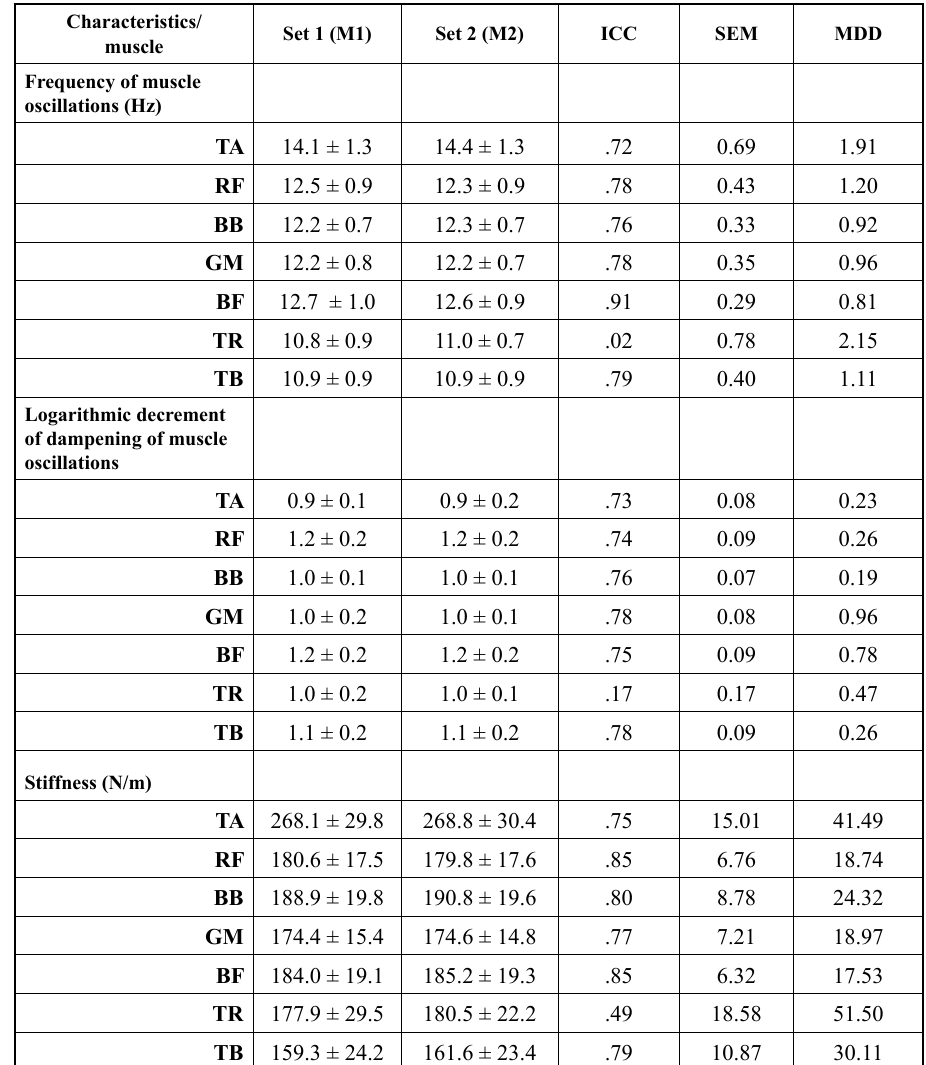
BB, GM and TB frequency measurements was